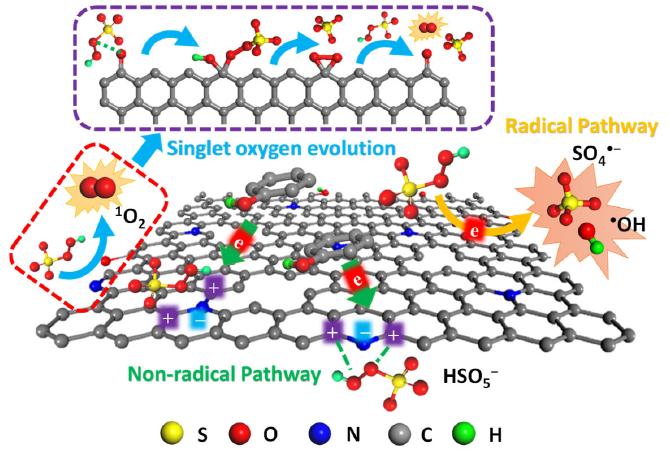
Figure 3. Illustration of di ff erent reaction pathways: singlet oxygenation, nonradical electron transfer, and radical pathways. Reprinted with permission from reference [59]